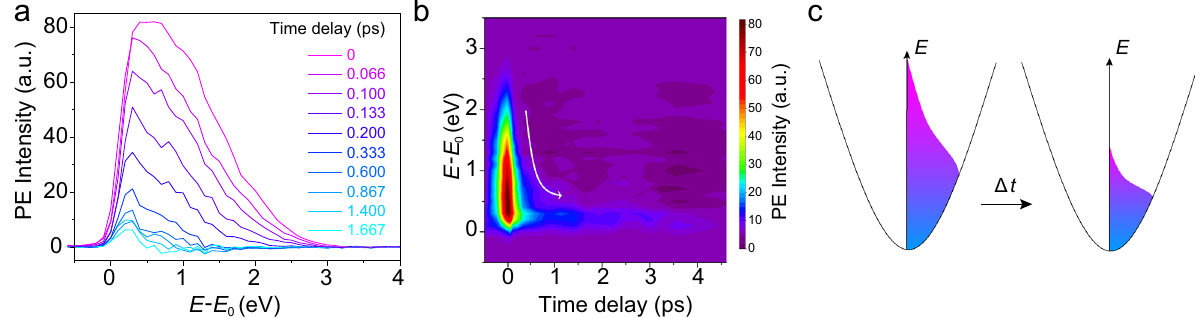
Fig. 3 Energy distribution of photoexcited electrons from the 1 T ′ -MoTe 2 as a function of time delays. a Typical energy-resolved photoelectron spectra recorded at various time delays. b Mapping of photoemission (PE) intensity versus the delay time and relative energy. The energy of the photoelectron collapses to the low-energy levels rapidly (white arrow). c Schematic of energy distribution evolution of the photoexcited electrons. “ E – E 0 ” indicates the kinetic energy of the photoemission electrons. “ Δ t ” indicates the time delay of pump – probe pulsed delay. In these measurements, the pump and probe fl uences are fi xed at 28 μ J/cm 2 and 0.27 μ J/cm 2 , respectively. We focused on the dynamics of four representative regions, i.e., the T and H regions (both far away from the heterojunction), and JT/JH regions (near the heterojunction), as shown in Fig. 4a. The normalized time traces of the PEI for the 1 T ′ - (T region) and the 2H-MoTe 2 (H region) are shown in Fig. 4b. In both areas, the PEI increases sharply at the instant of photoexcitation and then followed by two distinct relaxation processes. The normalized time traces can be well- fi tted with two exponential decays convolving with the instrument response function, expressed as, (cid:1) (cid:3) (cid:3) G ð Δ tr Þ , where τ e (cid:2) t = τ þ A e (cid:2) t = τ τ PEI ð t Þ ¼ A 1 2 1 ( 2 ) is the fast 1 2 (slow) decay time, G ( Δ tr ) is Gaussian instrumental resolution function, and Δ tr is the time resolution of the TR-PEEM system (~200 fs). With that, the fast decay time τ 1 of ~0.33 ps with the relative weights A 1 of ~85% (0.14 ps/85%), and slow decay time τ 2 of ~3.0 ps with the relative weights A 2 of ~15% (~1.0 ps/15%) were obtained for the pristine 2H (1 T ′ ) MoTe 2 , respectively.